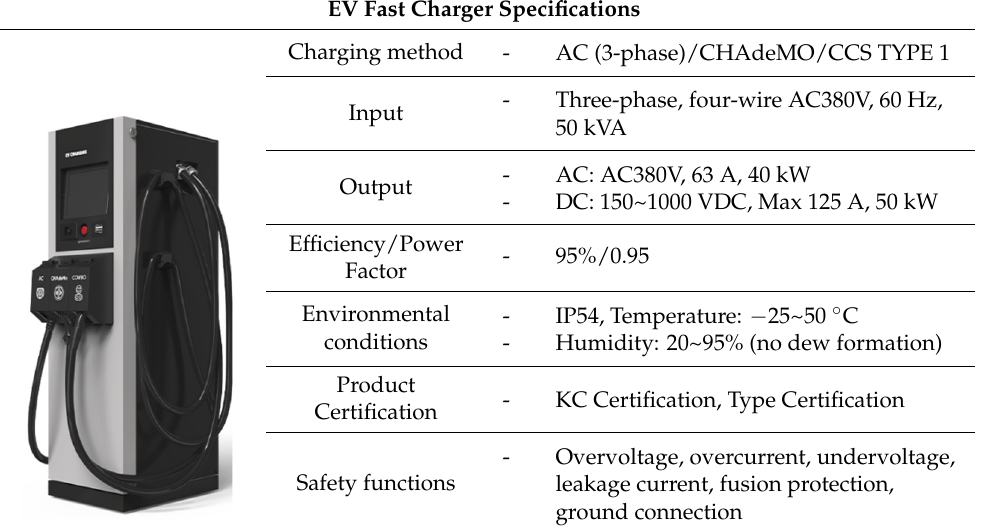
Table 1. Detailed specification of fast charger.